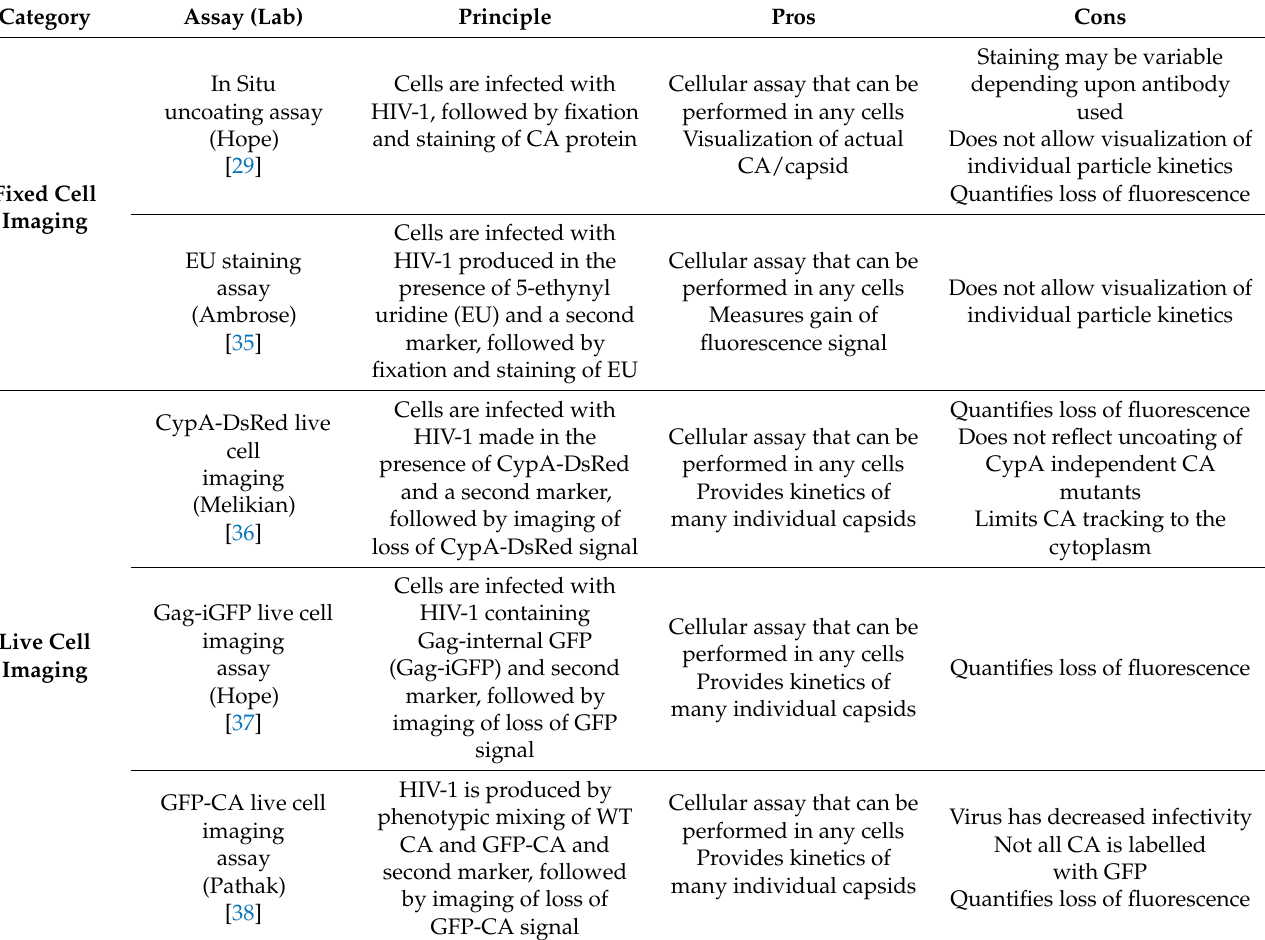
Table 2. Fixed and live cell microscopy assays to assess HIV-1 capsid uncoating/integrity.